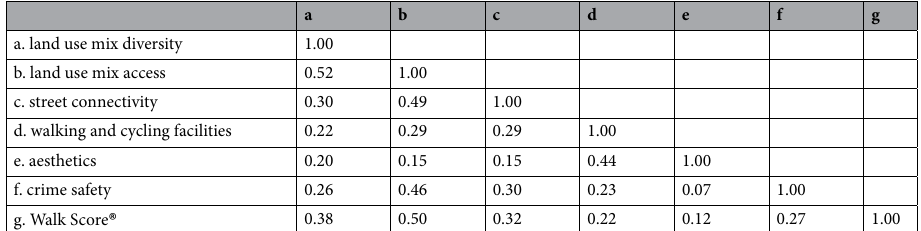
Table 2. Spearman’s correlations of workplace neighbourhood built-environment attributes. All the correlations were significant (p < 0.001). The sample size for the correlations between perceived workplace neighbourhood attributes was 2137 and that for the correlations between Walk Score ® and perceived attributes was